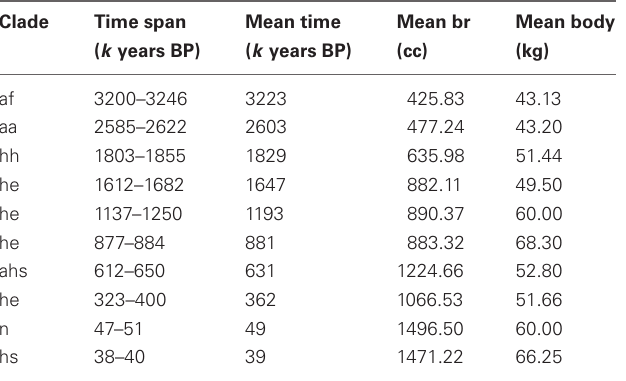
Table 1 | Brain and body size averaged for time periods and clades (data based on Henneberg and colleagues).